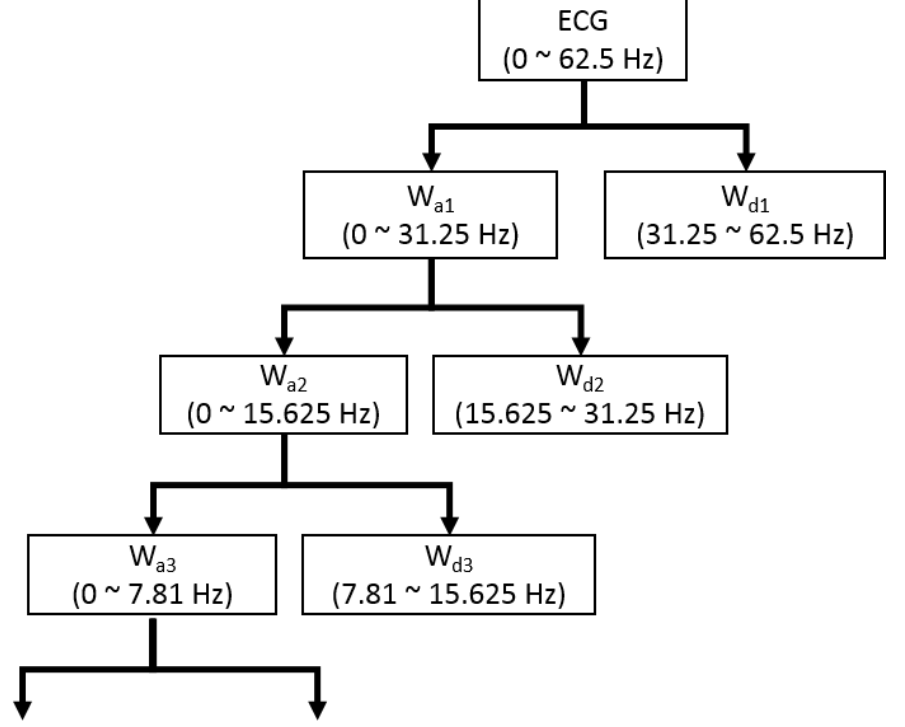
Figure 2. The structure of the discrete wavelet transformation (DWT)